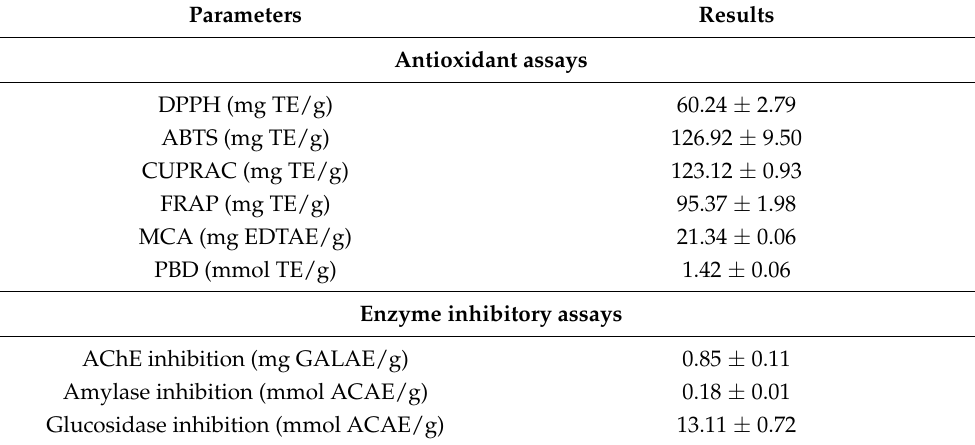
Table 3. Antioxidant potential of optimized MAE chamomile